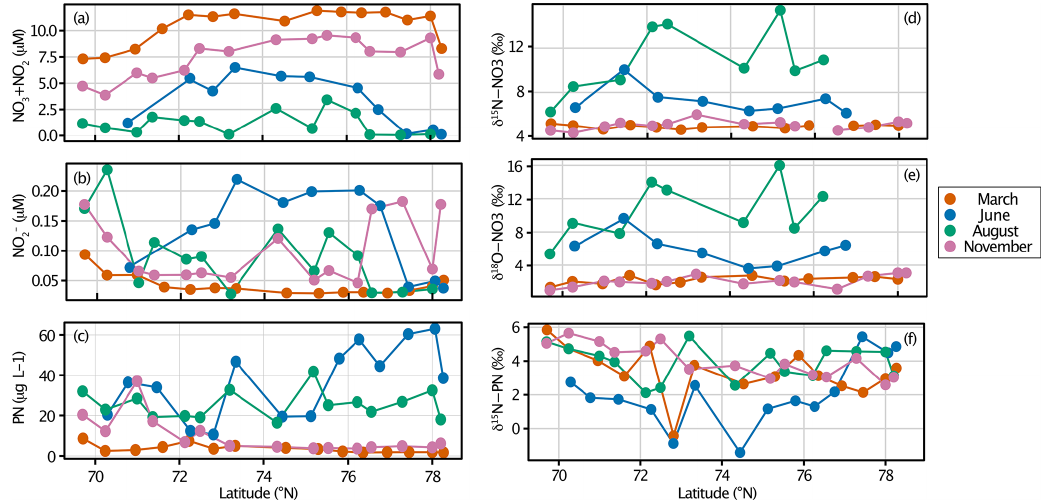
Figure 7. Seasonal variability in (a) nitrate (µM), (b) nitrite (µM), (c) PN (µgL − 1 ), (d) δ 15 N-NO 3 (‰), (e) δ 18 O-NO 3 (‰) and (f) δ 15 N-PN (‰) in surface waters along the Norbjørn Ferrybox transect of the Barents Sea Opening. The transect was completed over 4 different months of 2018: March is orange, June is blue, August is green, and November is